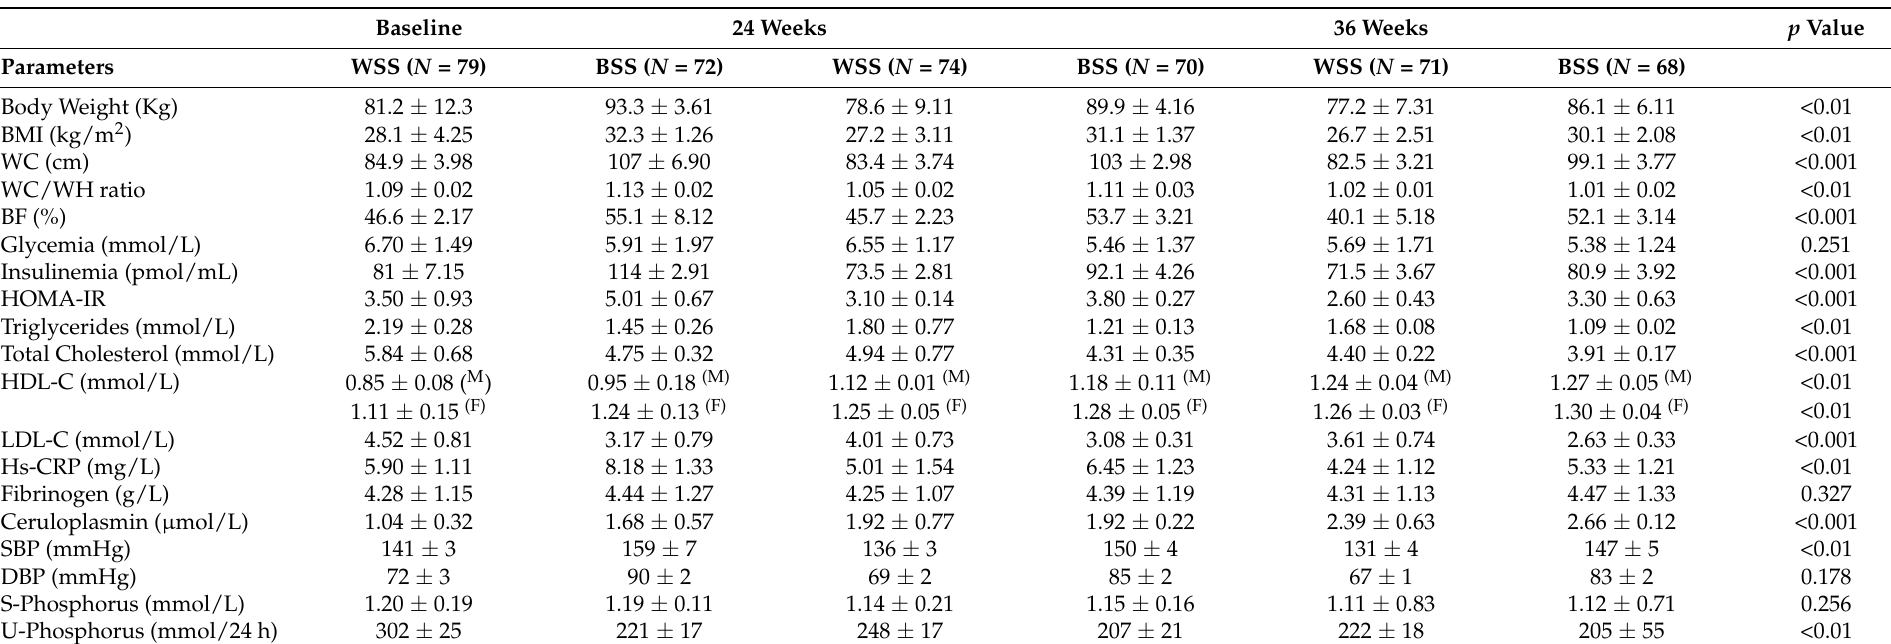
Table 3. Effects of oral 60,000 IU vitamin D3 supplementation/month at 24 and 36 weeks on the MetS clusters in CKD Blacks versus Whites SS